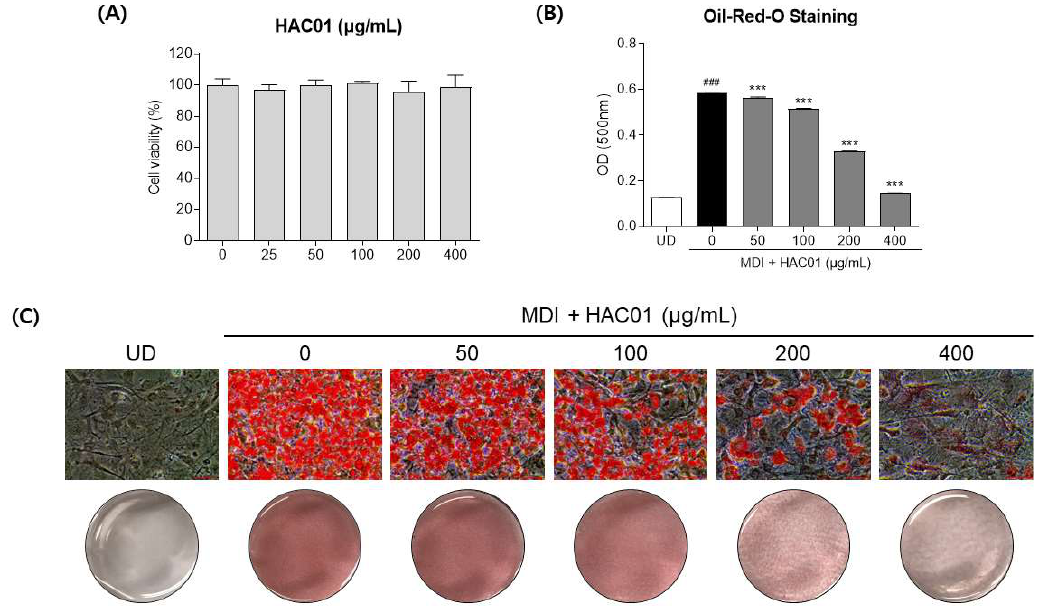
Figure 1. Effects of Lactobacillus plantarum HAC01 lysate on lipid accumulation in 3T3-L1 cells. ( A ). Cell viability. ( B ) Quantification of Oil Red O-stained lipid droplets. ( C ) Representative Oil Red O staining images. Images were captured at 200 × magnification. The scale bar indicates 50 µ m. OD, optical density; UD, undifferentiated; MDI, 500 µ M 3-isobutyl-1-methylxanthine, 1 µ M dexamethasone, and 10 µ g/mL insulin. All results are presented as mean ± standard deviation. ### p < 0.001 vs. UD; *** p < 0.001 vs. 0 µ